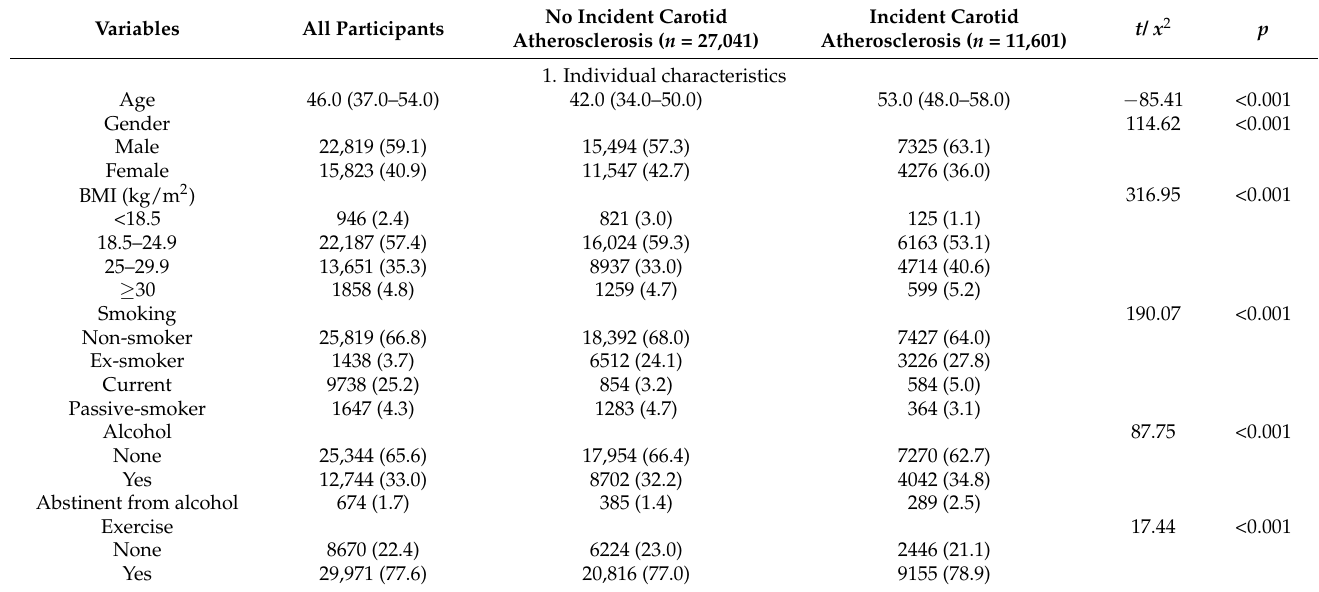
Table 1. Demographic characters of all participants with and without incident carotid atherosclerosis ( N =